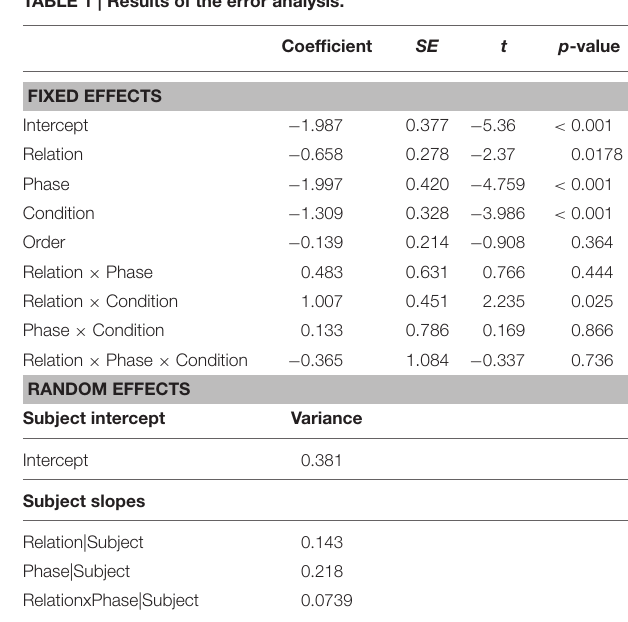
TABLE 1 | Results of the error